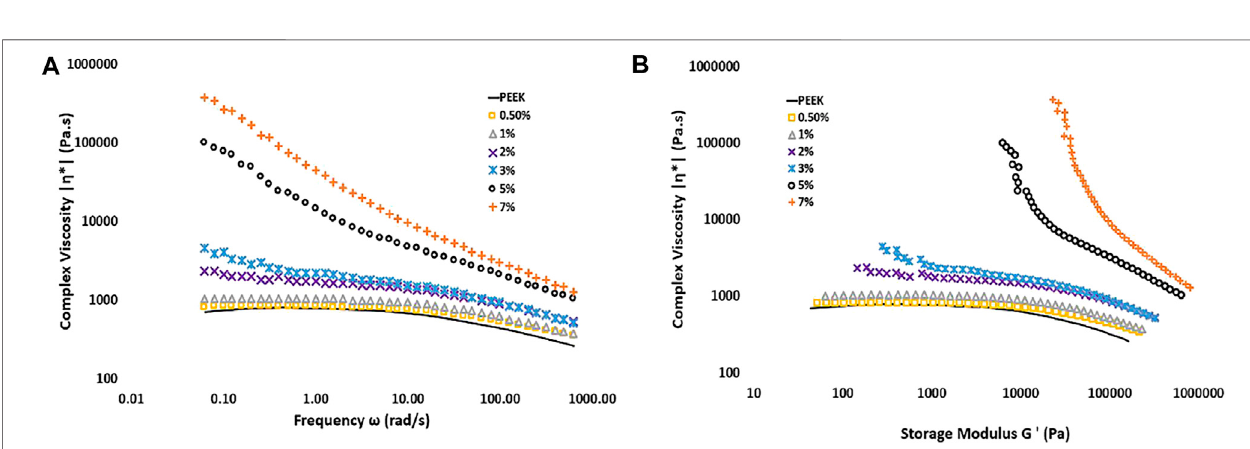
FIGURE 3 | Complex viscosity of the PEEK/EG composite melts (A) versus angular frequency (B) versus storage modulus for different EG loadings at 370 ° C.